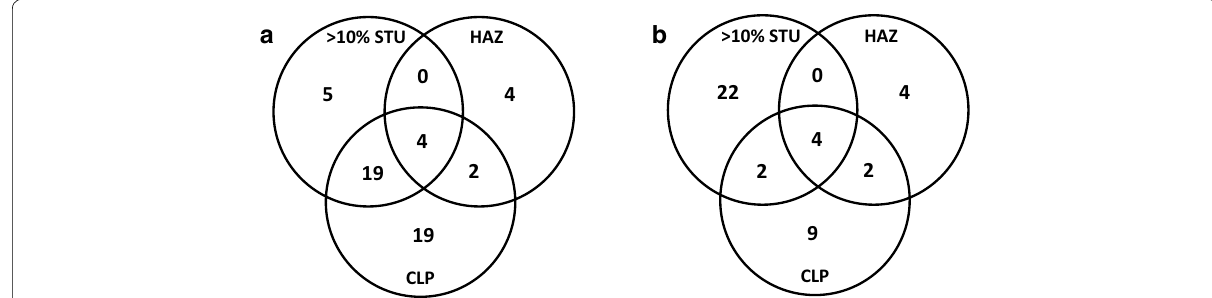
Fig. 1 Venn diagram of the three different categories applied to identify additives in the first 21 wood preservative products tentatively as relevant